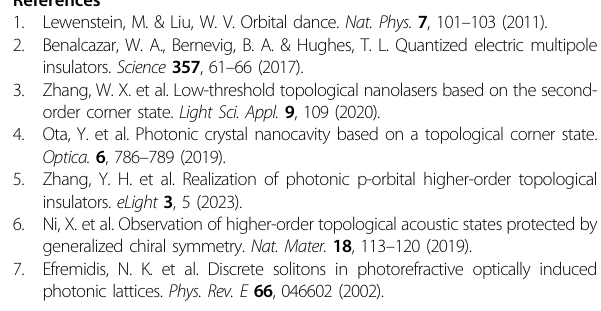
orbital corner modes, where an oblique input beam rotates towards the favored orientation (see Fig. 1, left panel).